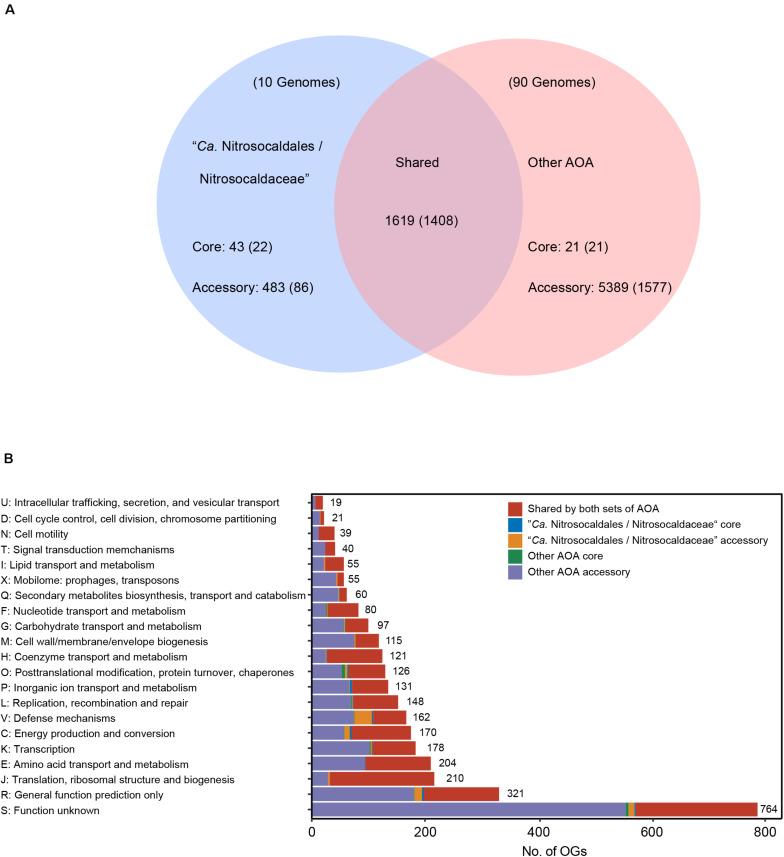
(A) Venn diagram illustrating the number of OGs shared between “Ca. Nitrosocaldales/Nitrosocaldaceae” and other AOA, and the number of OGs only present in either set. Numbers in parentheses indicate the number of OGs that could be assigned to arCOG database. (B) Distribution of the arCOG functional categories assigned to the defined sets. Detailed information is provided in Supplementary Table S7.